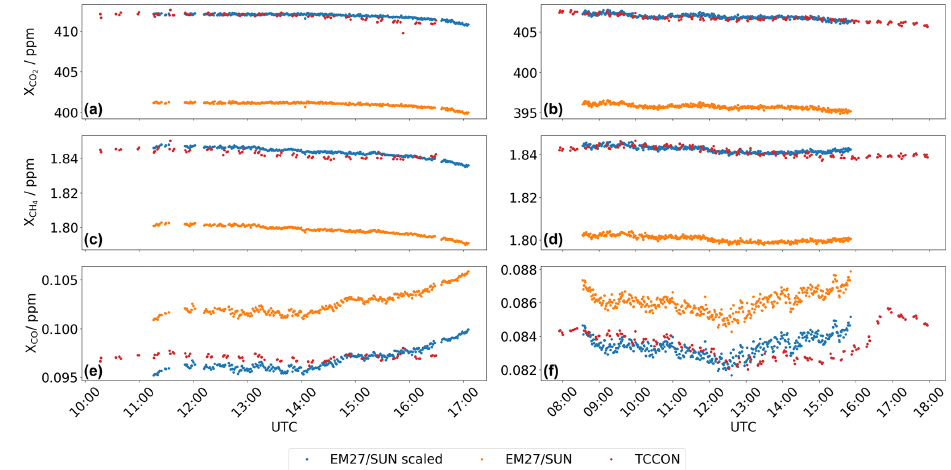
Figure 4. Side-by-side measurements of XCO 2 (a, b) , XCH 4 (c, d) , and XCO (e, f) by the shipborne EM27/SUN and the TCCON station at Karlsruhe on 30 April 2019 (a, c, e) and 7 July 2019 (b, d, f) . EM27/SUN measurements before and after scaling are shown in orange and blue, and TCCON records are shown in red.